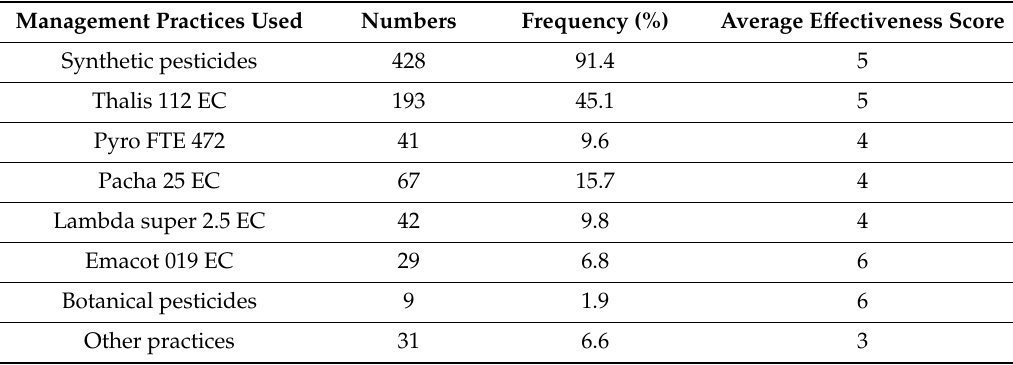
Table 8. Management practices used by